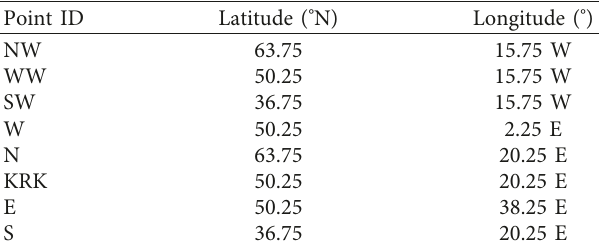
Table 1: Location of selected grid